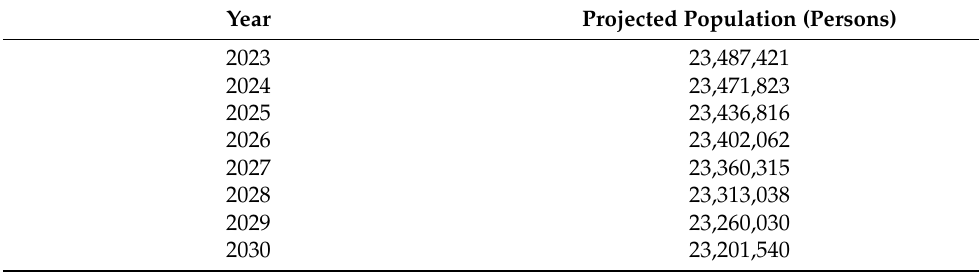
Table 3. Population projection for Taiwan in